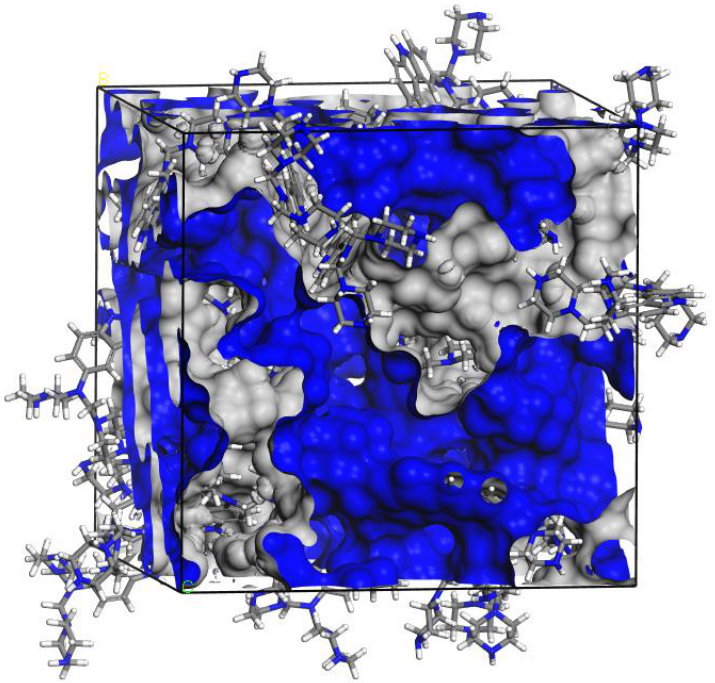
Figure 6. Energy-minimized amorphous cell comprising MXM.